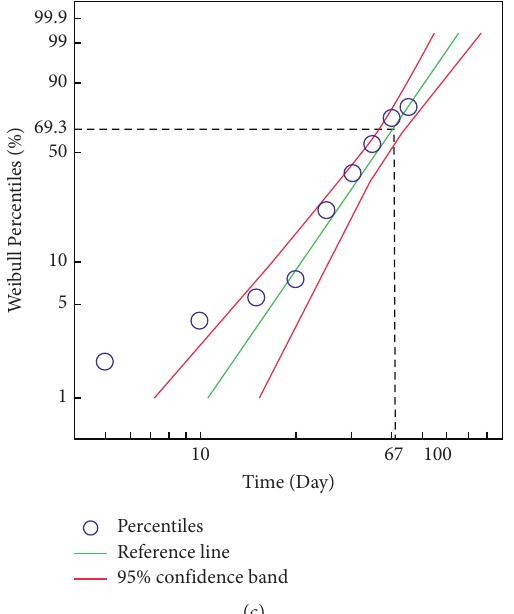
Figure 1: Probability Weibull plot of time. (a) Tea samples were stored at 20 ° C; (b) tea samples were stored at 30 ° C; (c) tea samples were stored at 40 °